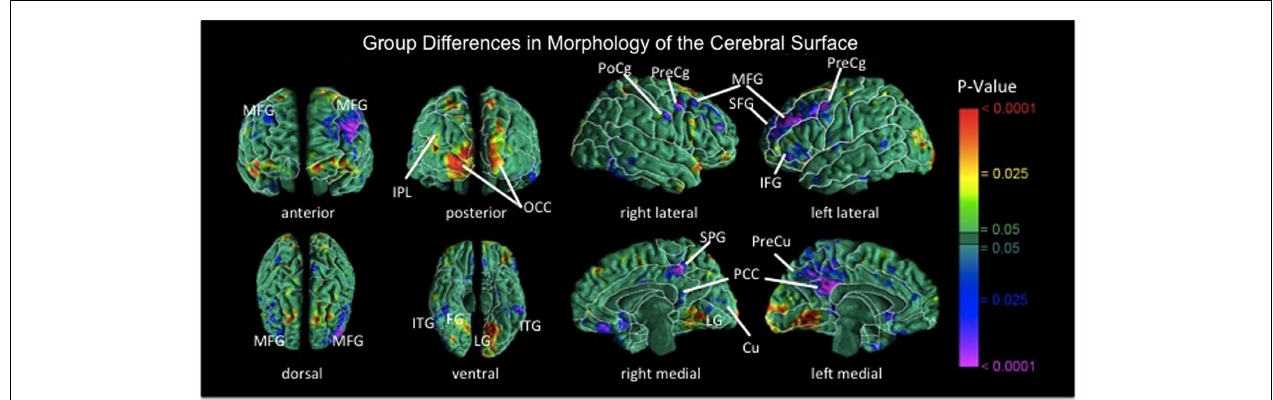
superior and inferior frontal gyri of the left hemisphere, the postcentral gyrus of right hemisphere, and bilateral temporoparietal areas ( p ’s = 0.01–0.0001). MFG, medial frontal gyrus; PoCg, postcentral gyrus; PreCg, precentral gyrus; IFG, inferior frontal gyrus; SFG, superior frontal gyrus; IPL, inferior parietal lobule; OCC, occipital cortex; ITG, inferior temporal gyrus; FG, fusiform gyrus; SPG, superior parietal gyrus; PCC, posterior cingulate cortex; Cu, cuneus; PreCu, precuneus; LG, lingual gyrus.